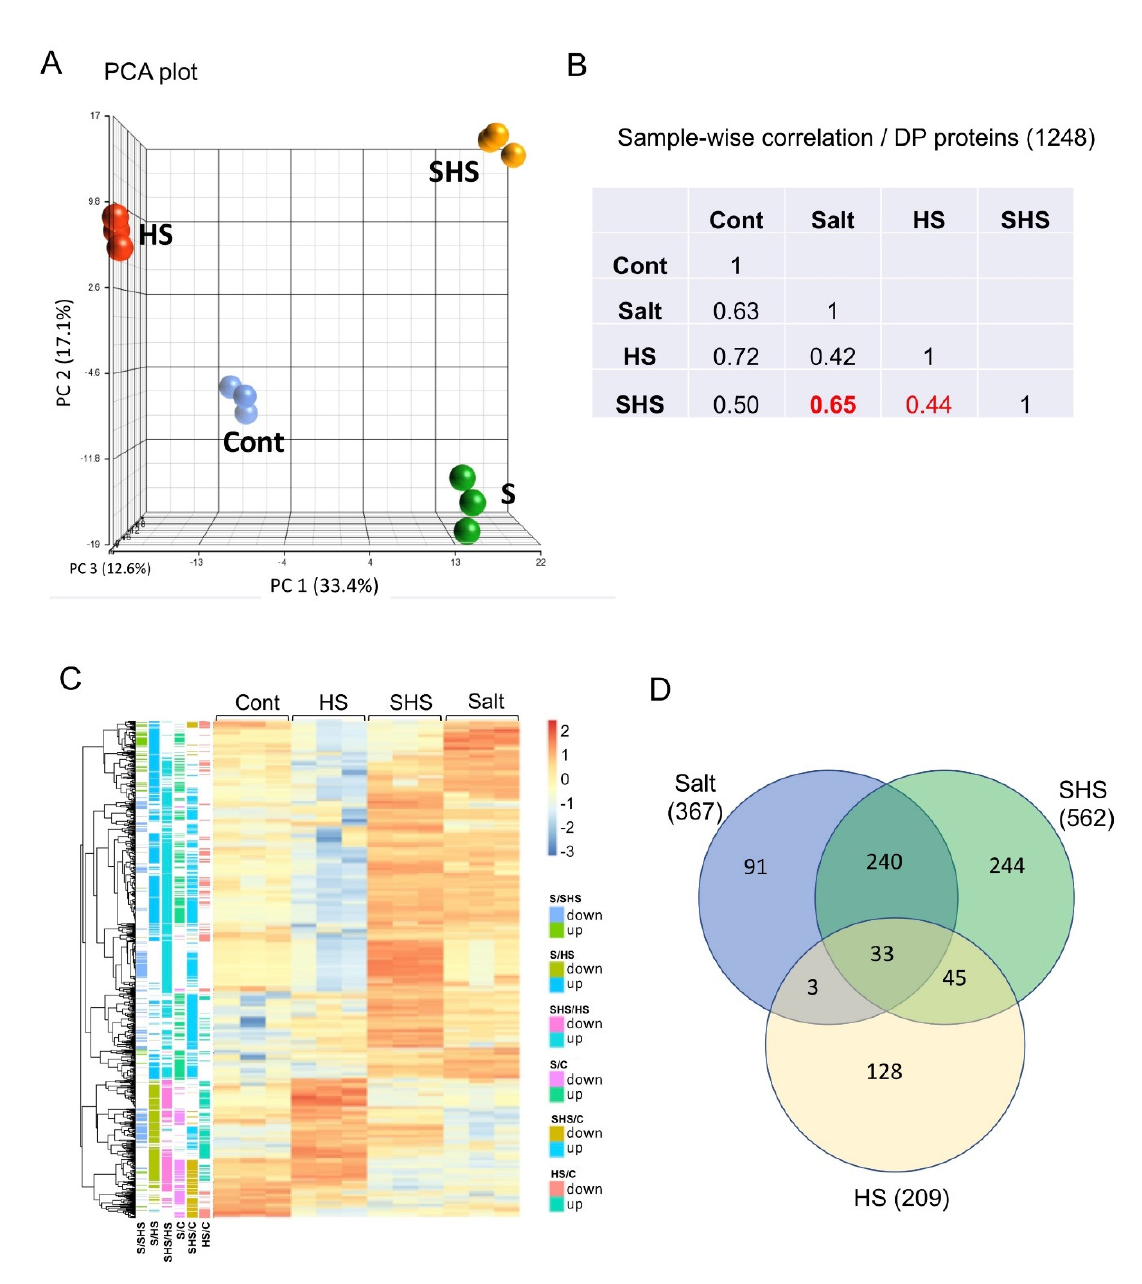
Figure 2. Proteome analysis of pericarps. ( A ) Principal Component Analysis (PCA) score plot comparing the proteome profiles between pericarps derived from control, salt (S), heat shock (HS), and S + HS-treated plants. ( B ) Sample-wise correlation using LFQ values per sample. Red square indicates high correlation between salt (S) and combined S + HS (SHS). ( C ) A hierarchical clustering of DP proteins (n = 1248, passing FDR adjusted p -value < 0.05 in any of the pairwise comparisons) identified in pericarps derived from control and stress-treated plants. The color key represents the log 2 values of treatments and control. On the left, up and down accumulated proteins between treatments. Color codes are shown on the right. ( D ) Venn diagram of the differentially present proteins in pericarps. The number in brackets are the number of DP proteins between treatments and control passing the cutoff (FC > 2; p -value < 0.05).